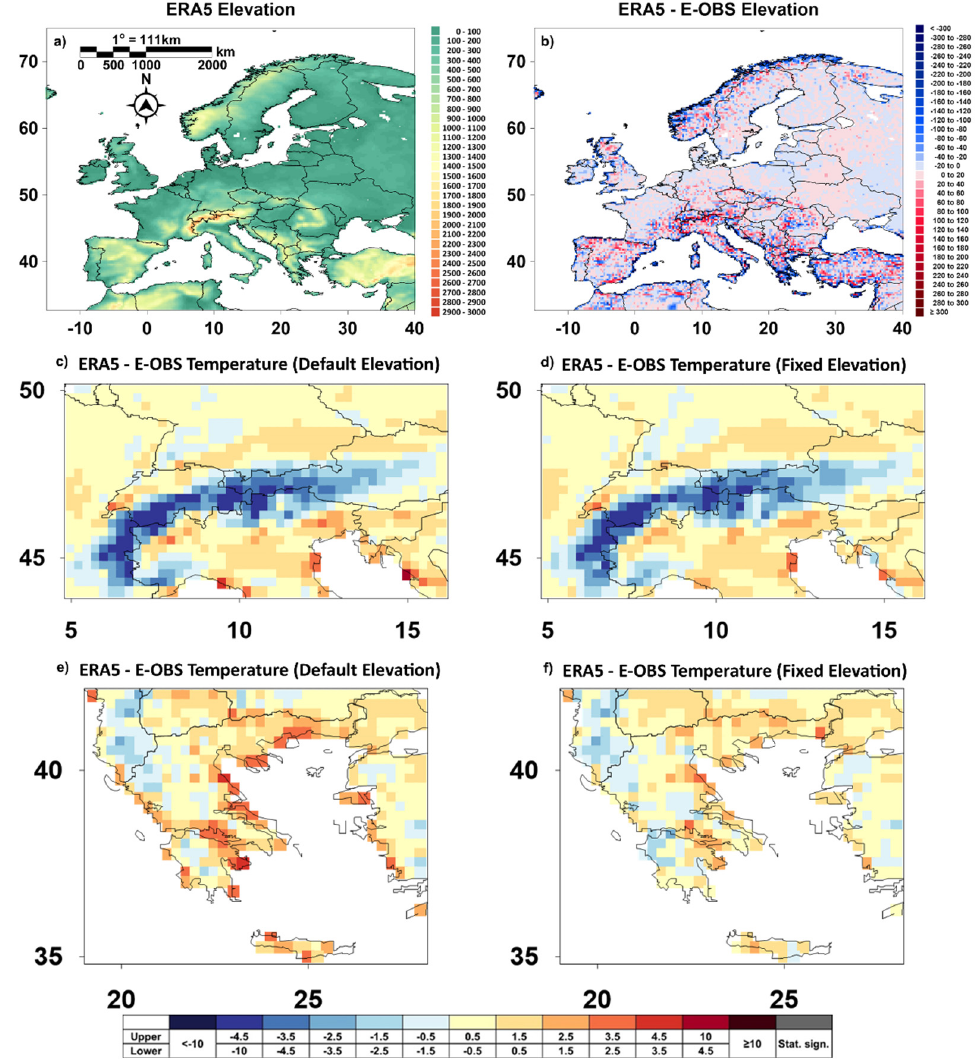
Figure 2. ( a ) The elevation of ERA5 and ( b ) the differences between ERA5 and E-OBS. Differences between ERA5 and E-OBS in the Alps region ( c ) with the default elevation and ( d ) with fixed elevation. Differences between ERA5 and E-OBS in the Mediterranean coast (Greece) ( e ) with the default elevation and ( f ) with fixed elevation.